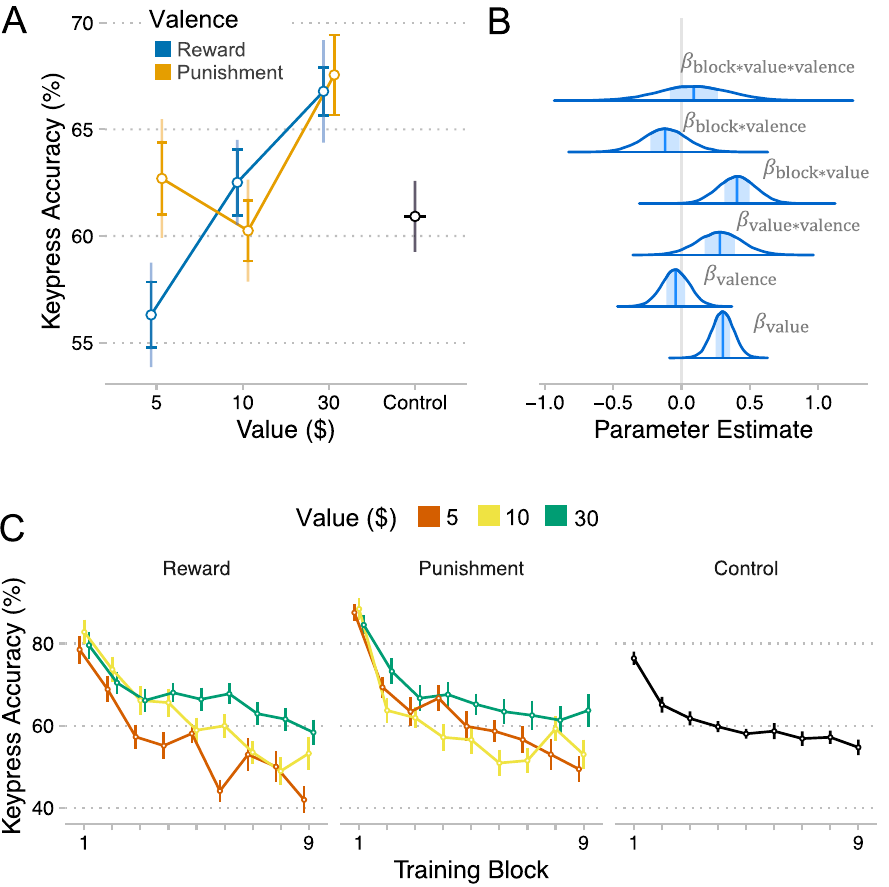
Figure 3. Effects of incentives on the accuracy of movement execution. ( A ) Accuracy (mean + /- se) for each level of value by valence. The bold error bars represent within-subject standard error (for value effect) and the non-bold error bars are between-subject standard error (for valence effect). ( B ) Densities of MCMC samples used to approximate posterior probability distributions over key regression coefficients. ( C ) Accuracy for each level of block by value (sequence) by valence (group). Plots were created using ggplot2 46